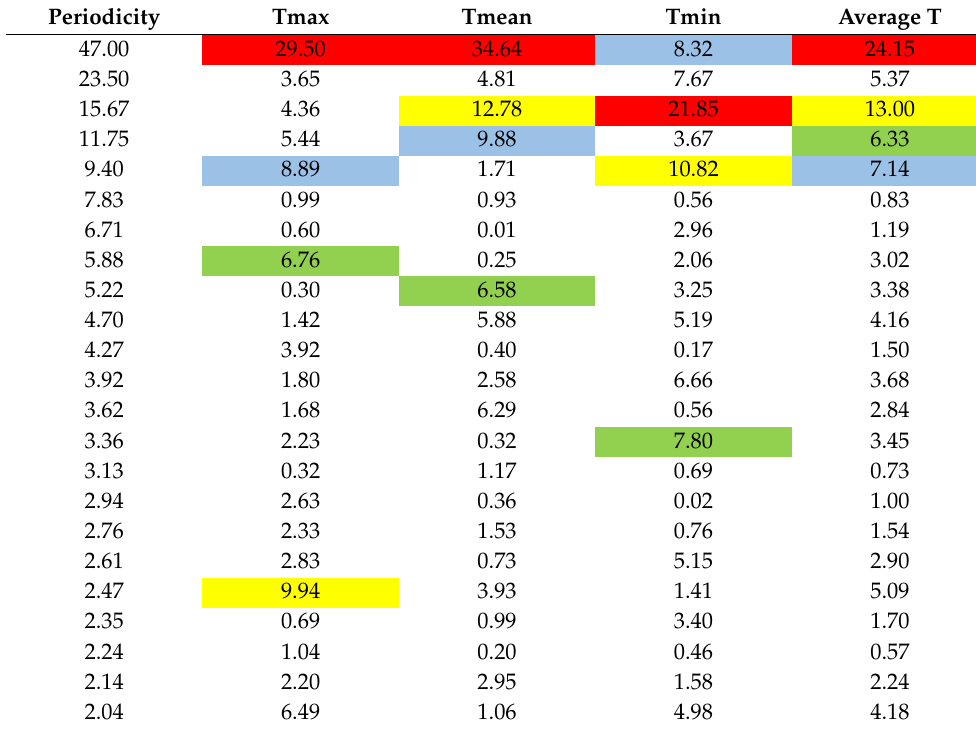
Table 6. Summary of the frequencies of greater significance in each series (% of the periodogram), for the maximum, average, and minimum temperatures of the original series. Periodicity Tmax Tmean Tmin Average T 47.00 29.50